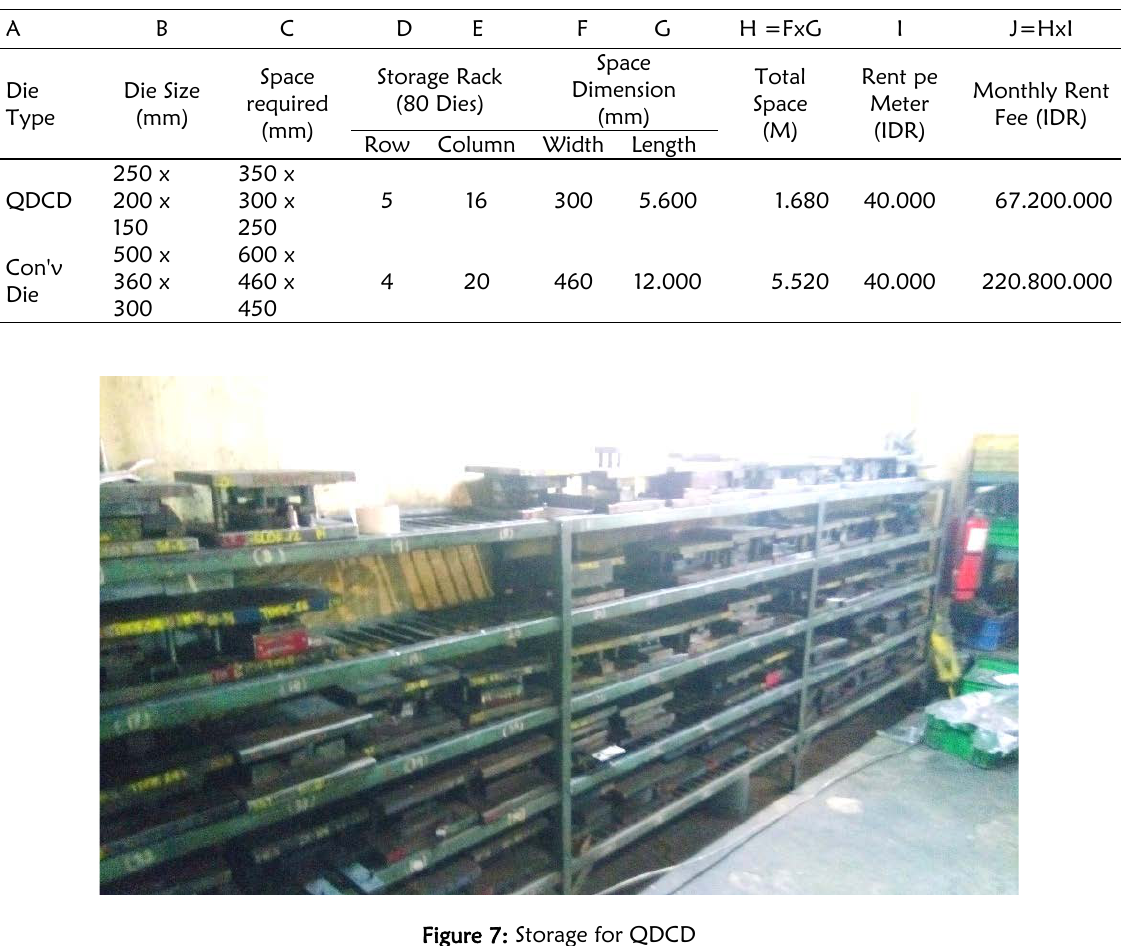
Figure 7: Storage for QDCD